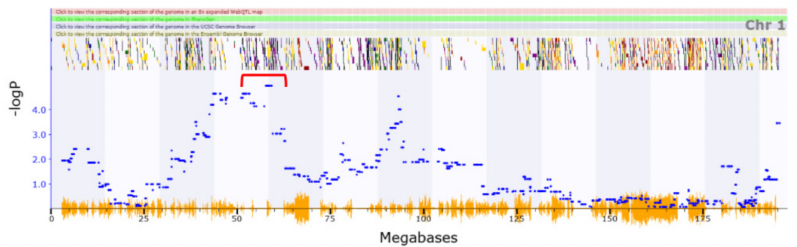
Figure 1. Phenotypic traits associated with locomotion map to a QTL region on chromosome 1. The peak in this region occurs between Chr1:37.67–78.94 as indicated by the red bracketed bar above. The multi-coloured lines corresponding to the dots are genes contained in this region. Blue dots correspond to areas with specific − logP scores relating to the